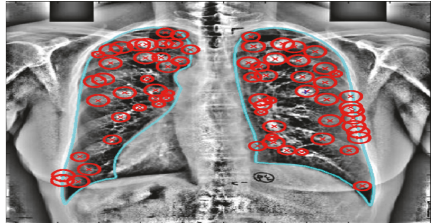
Figure 4: Suspected nodule